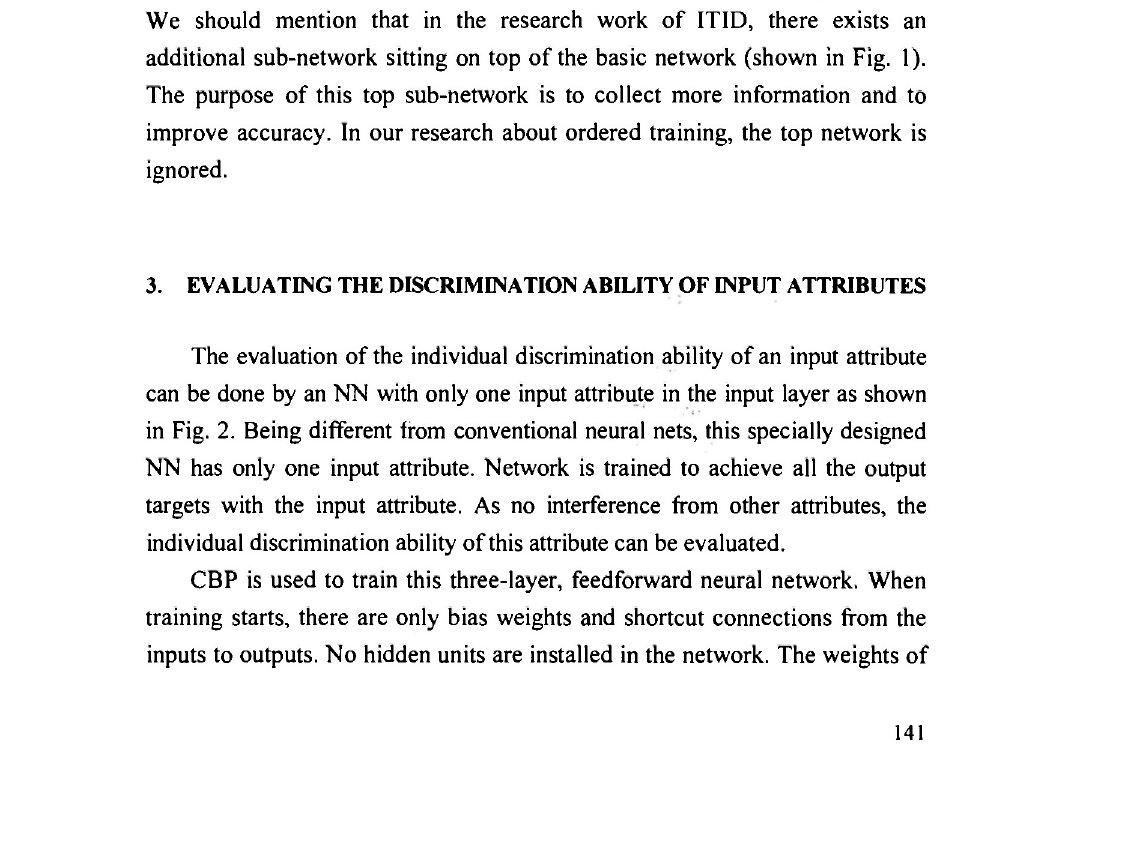
Fig. 1: Network structure of ITID (Guan and Liu, 2002a). A m is the m-th input attribute; S m is a set of hidden units corresponding to the m-th input attribute or the m-th